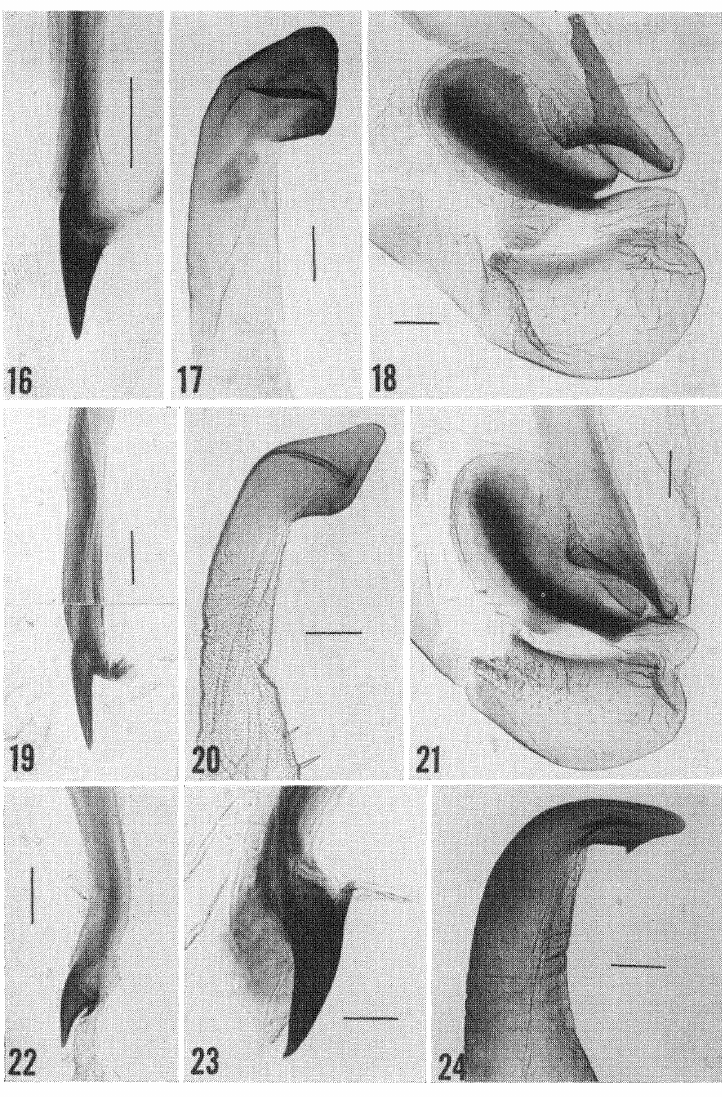
Figs. 16-24. Poeciloderrhis spp. 16-22. P. ferru_oinea. 16-18. (110, ANSI:’. Silo Paulo, Brazil (det. Roth). 19-21. (31, AMNH). Corupa, Hansa Humbolt, St. Catharina, Brazil. (det. Roth). 22. (167, USNM). St. Catharina, Nova Teutonia, Brazil (det. Roth). 23-24. (45, ANSP). P. atriee’ntris. (det. Hebard). (scale 0.2